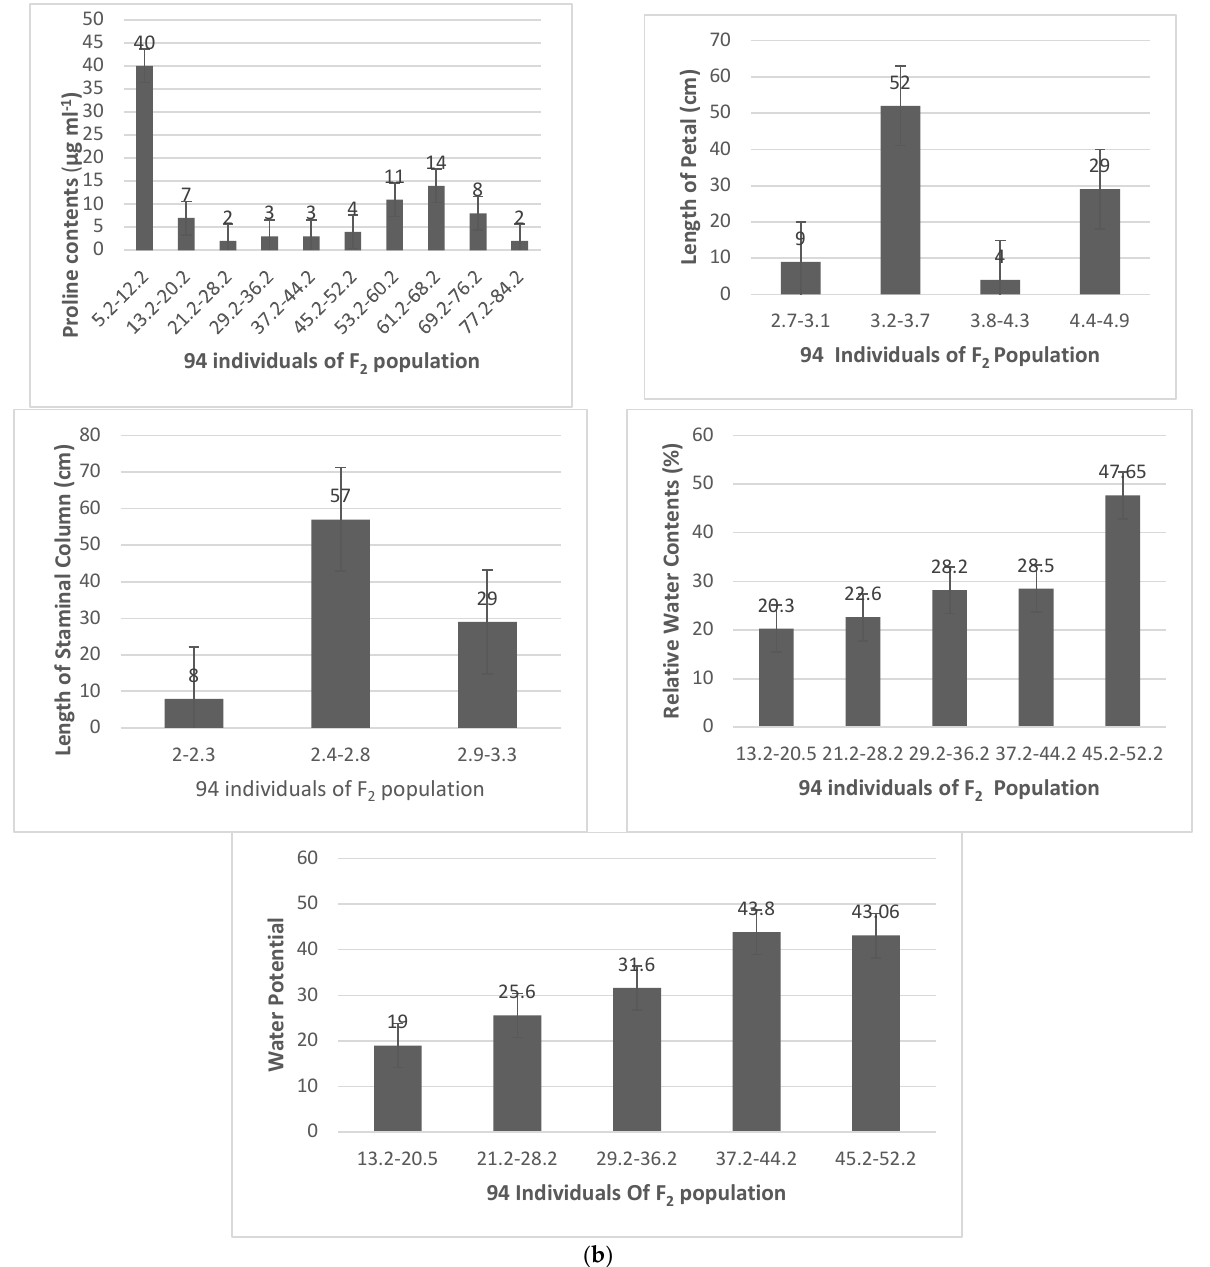
Figure 2. ( a , b ) Frequency distribution of morpho-physiological traits related to heat stress across F 2 population.